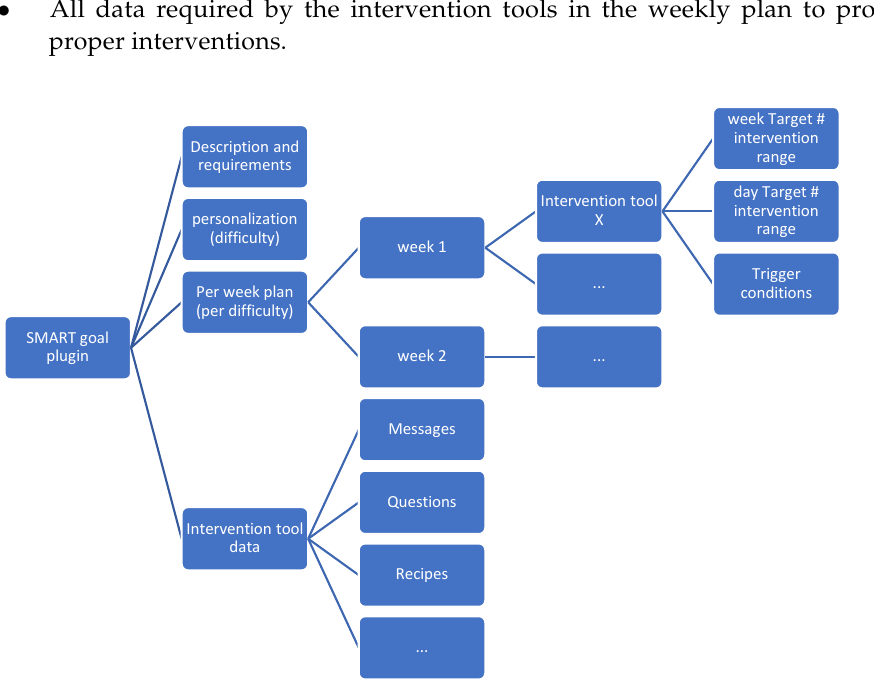
Figure 6. SMART goal plugin structure schema.